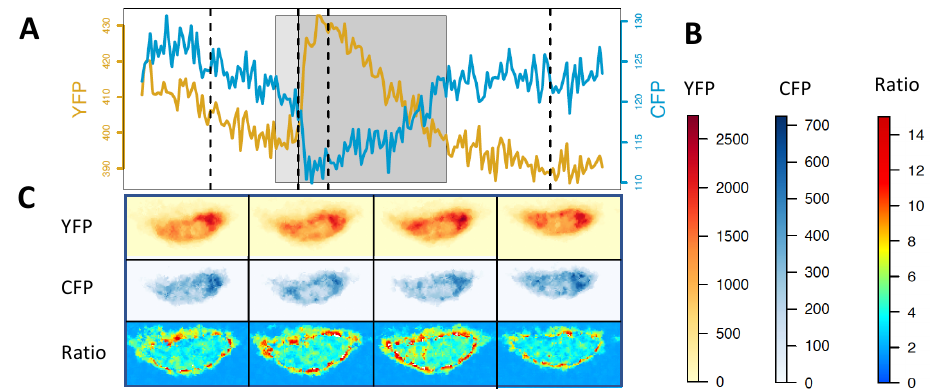
Figure 5. Signal enhancement at the nuclear periphery before, during and after a single Ca 2 + spike, when adopting image processing Option B of Figure 4. ( A ) During a Ca 2 + spike (grey rectangle), the CFP intensity (blue) decreases while YFP intensity (red) increases. ( B ) Colour-bars show that the CFP is less bright than the yellow YFP. ( C ) The signal from YFP and CFP is not uniformly distributed across the nucleus and it is weaker at the periphery. These intensities are presented after filtering, background subtraction and clipping (Path B in Figure 4). The ratio YFP/CFP is always brighter at the periphery of the nucleus and even more so during the Ca 2 + spike (two central ratio pictures; Panel (C)). The Ca 2 + spike data were recorded every 0.37 s, and each of the four sequential images for YFP, CFP and ratio in (C) correspond to the vertical dotted lines before, at the onset, at its peak, and after the Ca 2 + spike in (A). The Ca 2 + sensor was the nuclear-localised